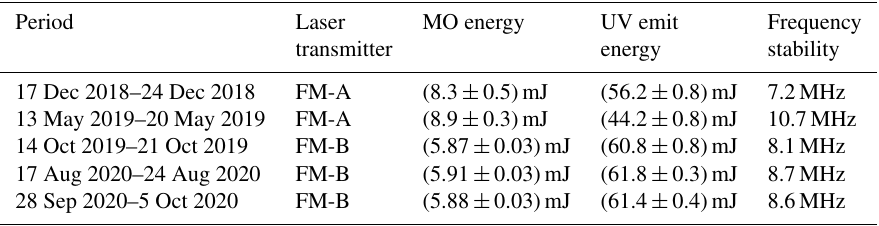
Table 1. Overview of the periods that were studied in terms of the laser frequency stability. The active laser transmitter operated in the respective period (FM-A or FM-B) and the corresponding master oscillator IR output energy and UV emit energy (as reported by the laser internal photodiodes) are provided. Note that the reading of the MO photodiode for FM-A is considered inaccurate (see text). The frequency stability is given as the mean of the standard deviations from all wind observations of the respective